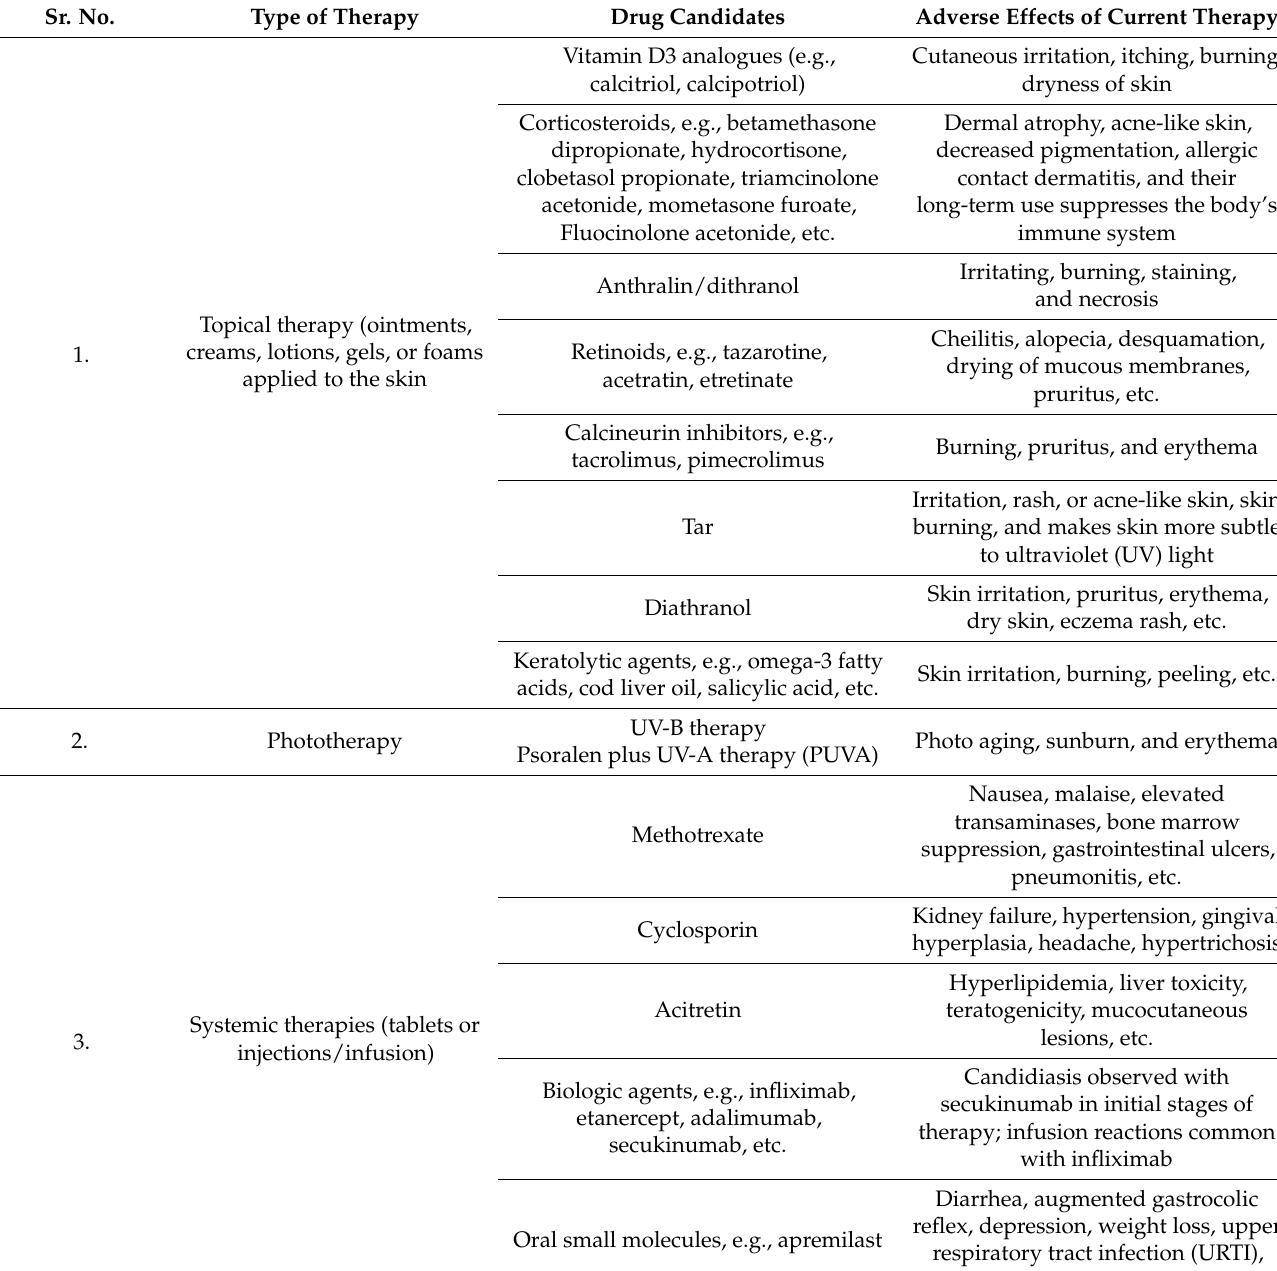
Table 1. Present therapies for the treatment of psoriasis and their limitations. Sr.